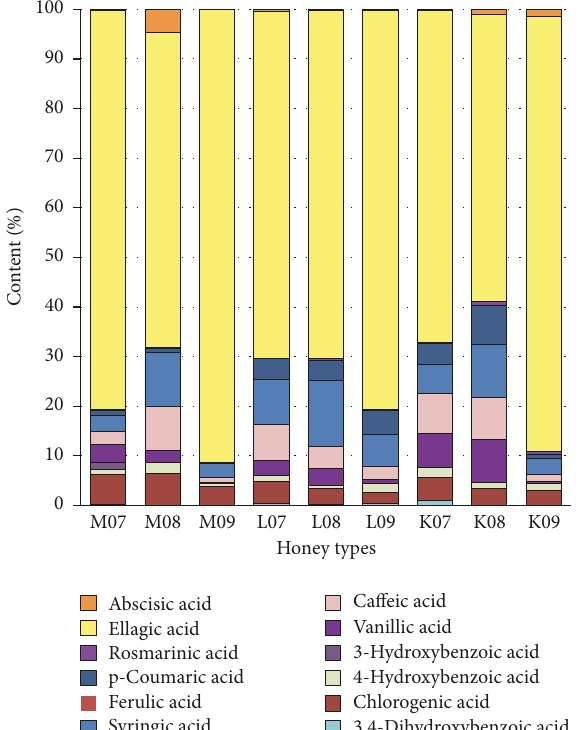
Figure 1: The chemical profiling of phenolic acids and abscisic acid in polyfloral honeys from northern Belgium. M07–M09 (honey samples from Mortsel apiary), L07–L09 (honey samples from Lichtaart apiary), and K07–K09 (honey samples from Kasterlee